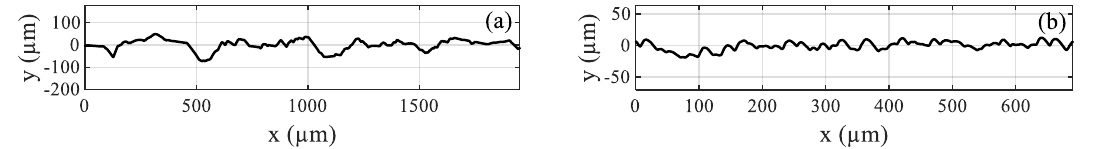
Figure 13. Roughness profiles (2 µ m tip), equal axis scaling ( a ) F16, 2 bar and ( b ) pin structure.